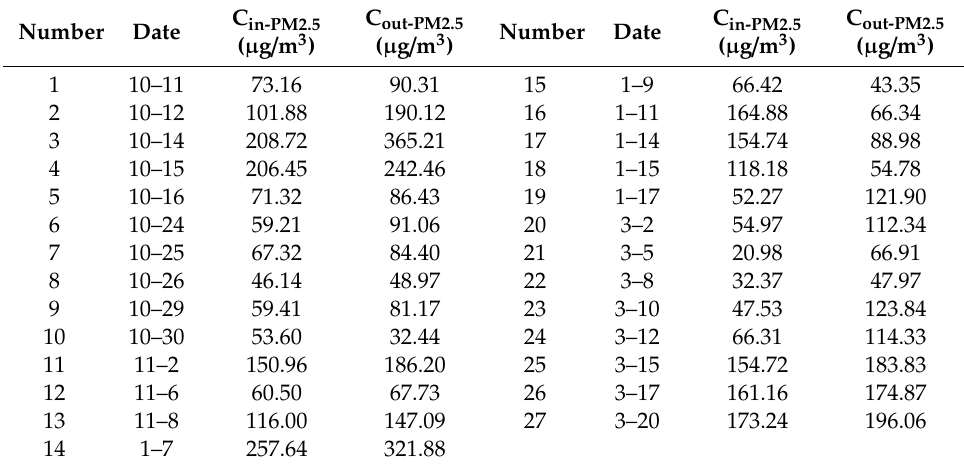
Table 3. Mass concentrations of PM2.5 during the sampling period.